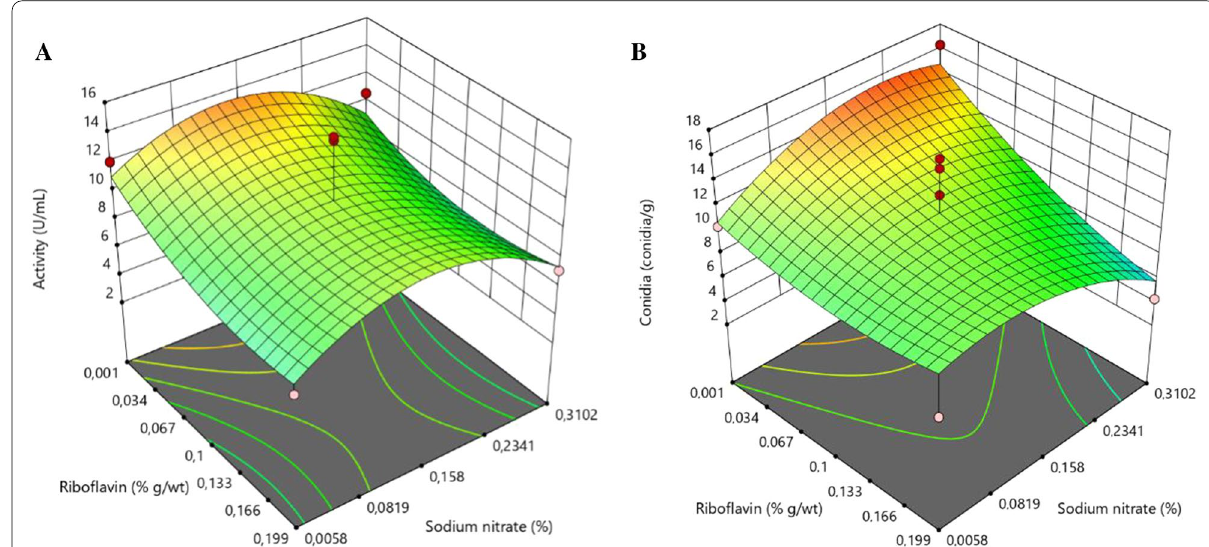
Fig. 1 Response surface plots of Metarhizium robertsii ARSEF 2575 produced in parboiled rice supplemented with riboflavin and sodium nitrate. A Response surface plot of Metarhizium robertsii ARSEF 2575 for proteolytic activity. B Response surface plot for conidial production of Metarhizium robertsii ARSEF 2575. The unit measurement used was gram by weight